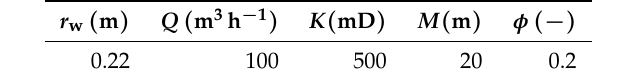
Table 2. Hydraulic parameters of a potential hydrothermal reservoir taken from Franz et al.